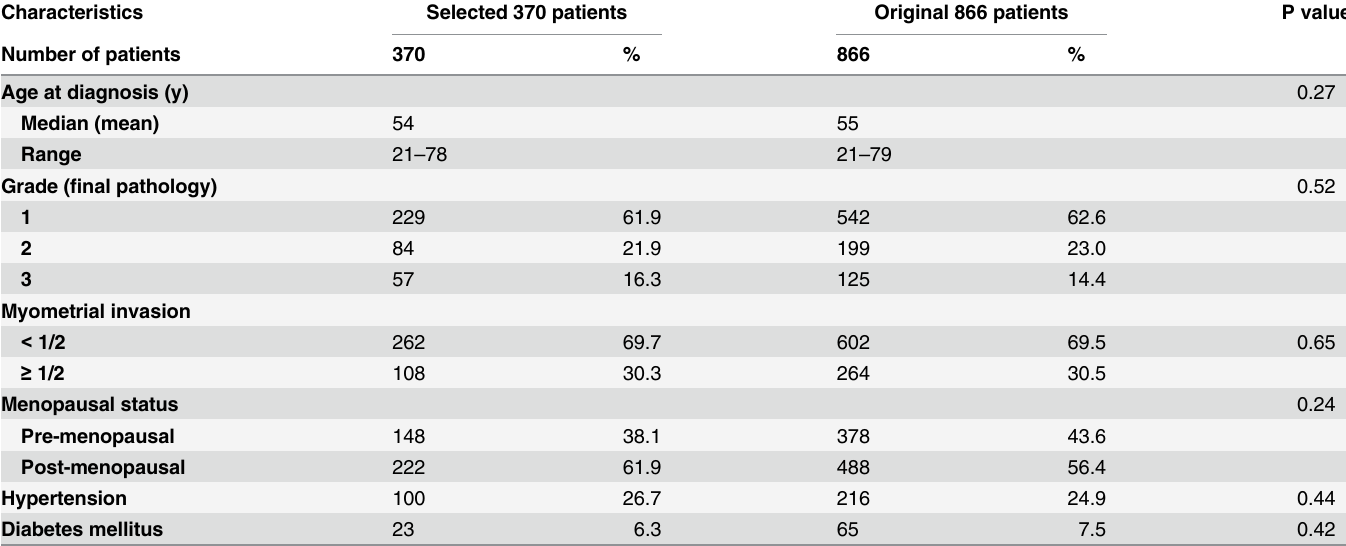
Table 3. Basic characteristics of selected 370 patients and the 866 patients with endometrioid histology from original 1098 patients.